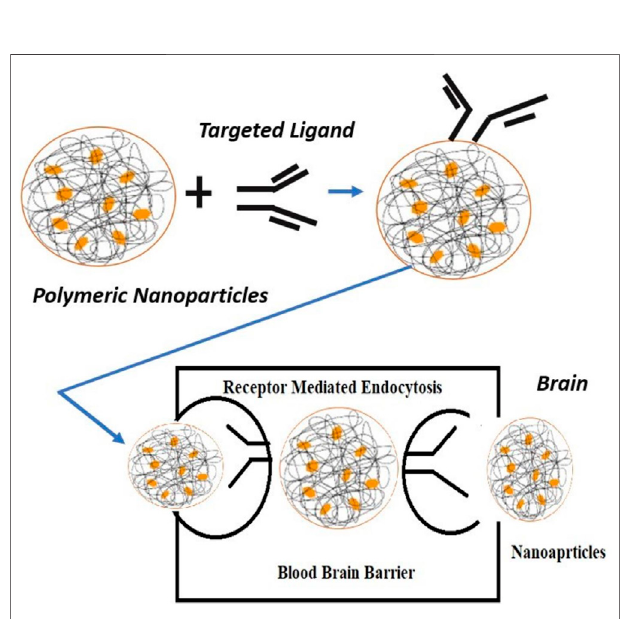
FIGURE 3 | Mechanism of ligand-targeted polymeric nanoparticles transport through the blood – brain